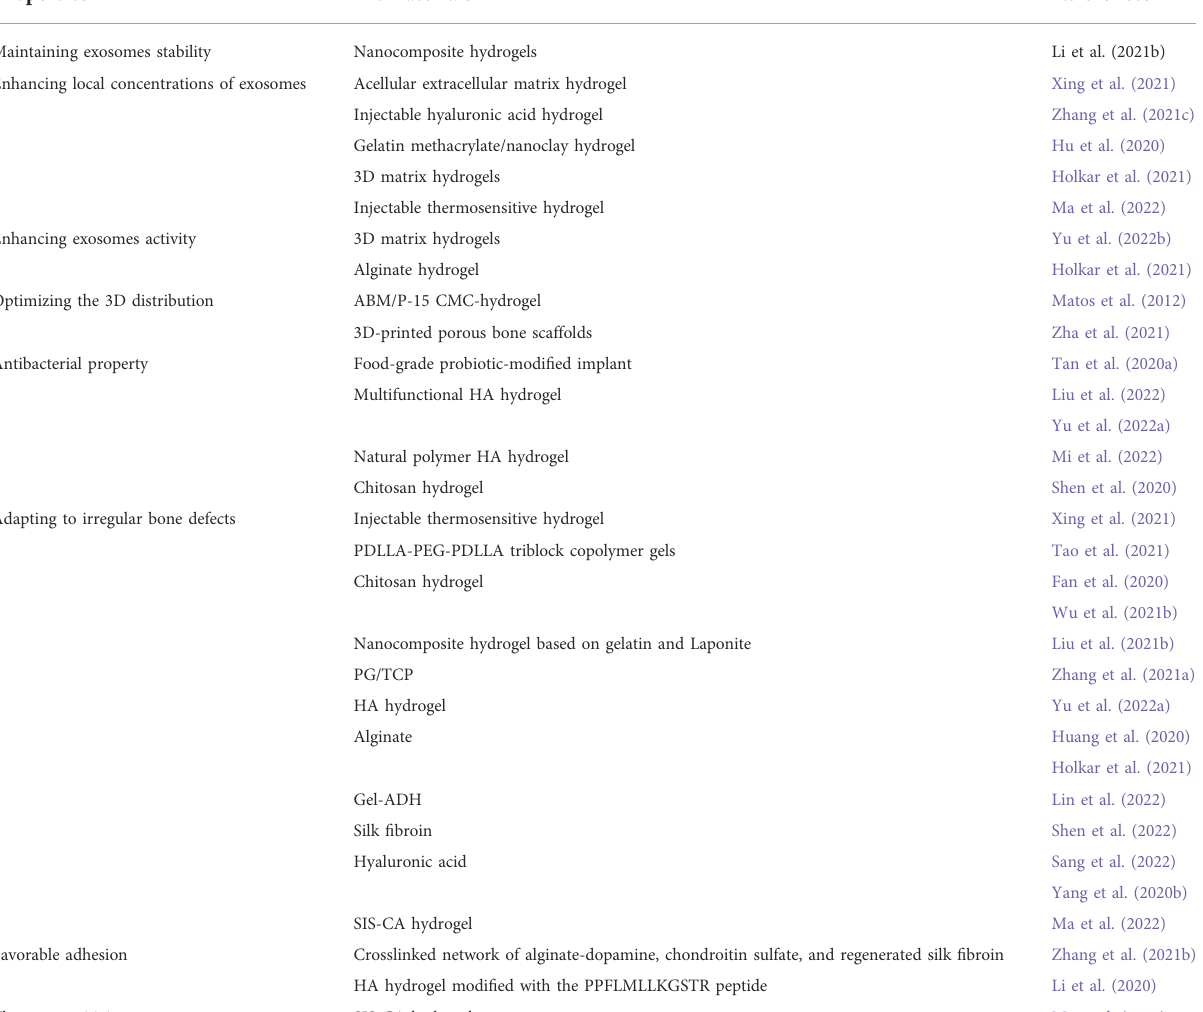
TABLE 2 The properties of exosome-integrated biomaterials for bone defect